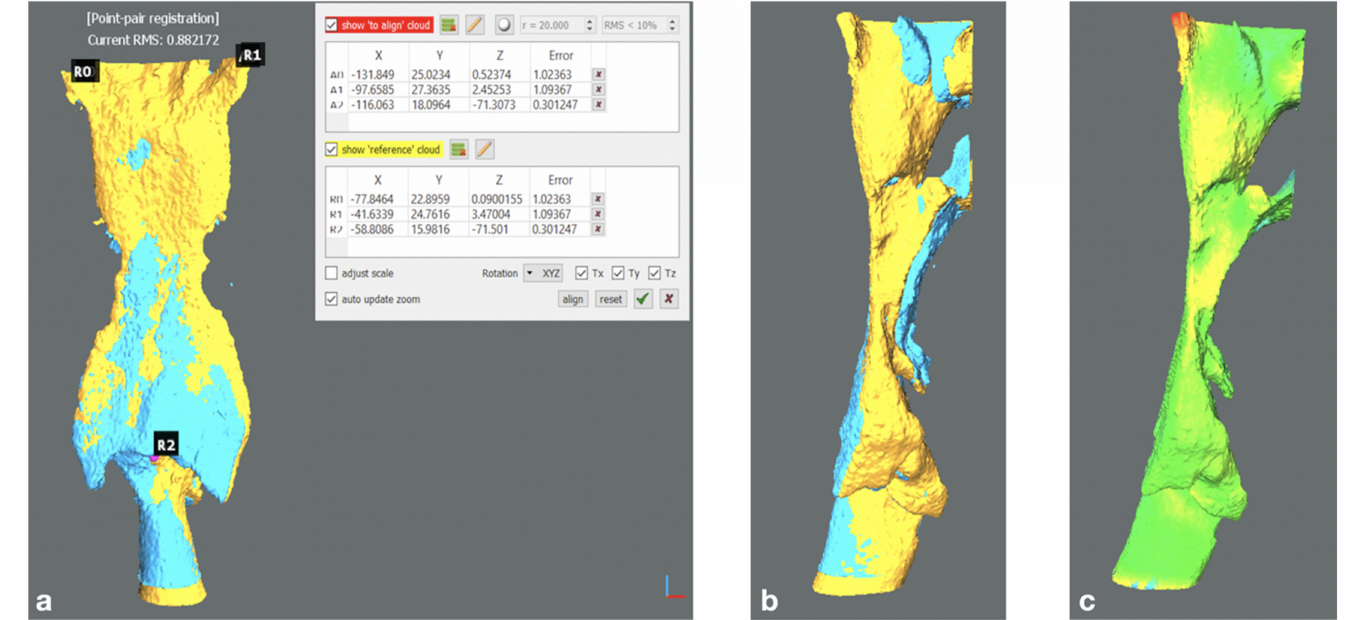
Figure 2. Superimposition of post- to pre-operative upper airways 3D models following point-pairs picking alignment in CloudCompare software. ( a ) Posterior view. ( b ) Sagittal view. ( c ) Colorimetric surface map following iterative closest point (ICP) to refine alignment in CloudCompare software (Sagittal